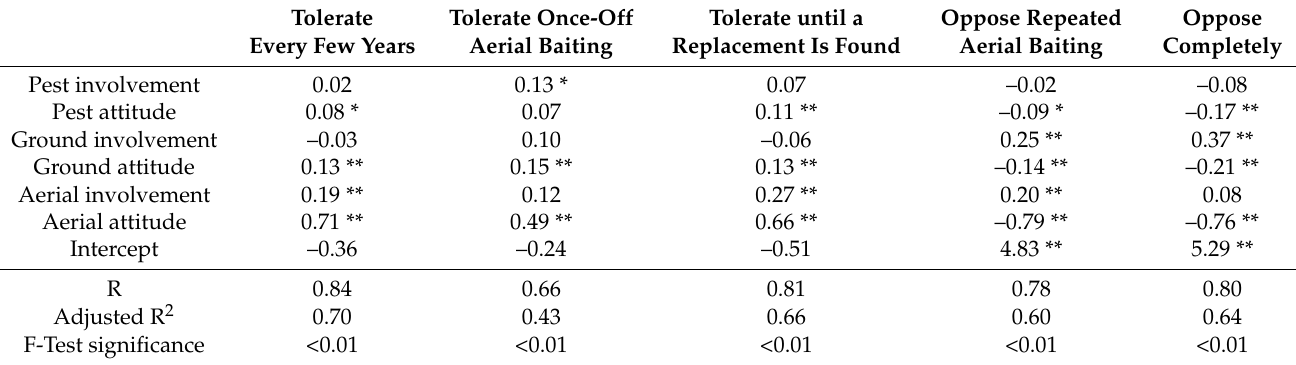
Table 10. Parameter estimates for different modes of aerial